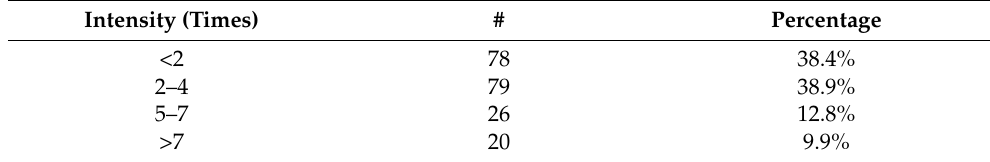
Table 3. Respondents’ intensity in seeking travel recommendations from